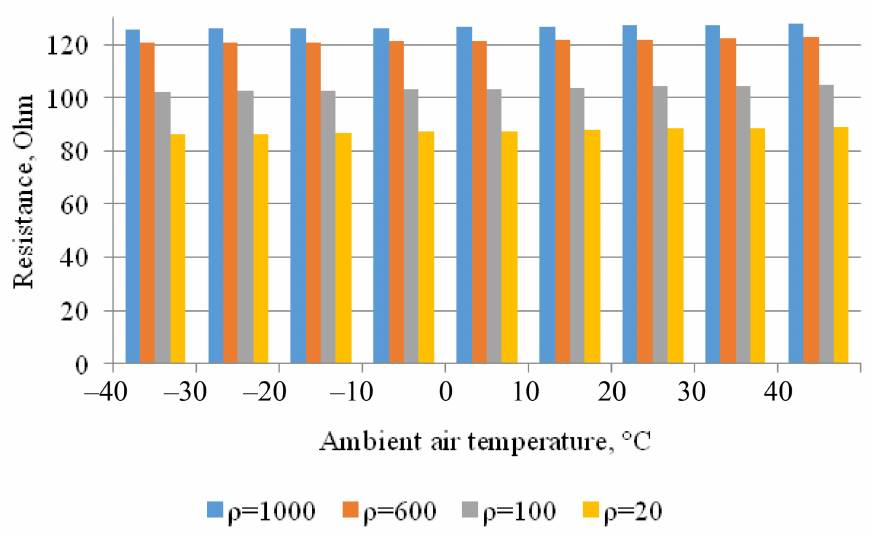
Figure 14. Changes in protection setpoint resistance during a one-phase short circuit for various soil resistance of overhead